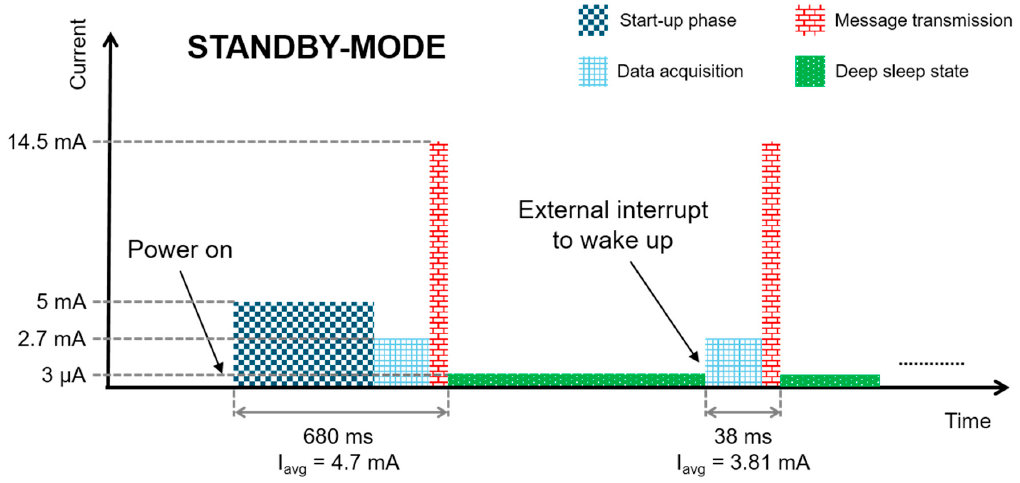
Figure 11. Schematic, not to scale, of the node current consumption in standby-mode ; the average Figure 3.81 mA ∗ 38 ms ~ 145 μC. 3.81 mA ∗ 38 ms ~ 145 μC.